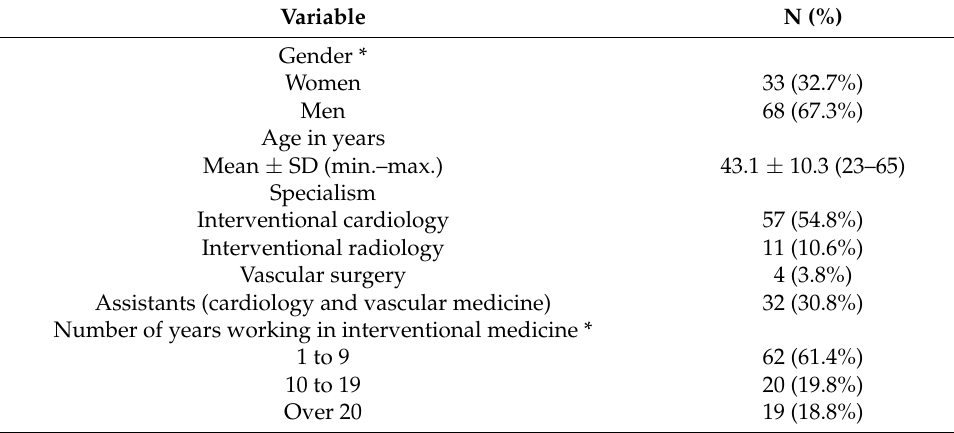
Table 1. Description of study participants (N =